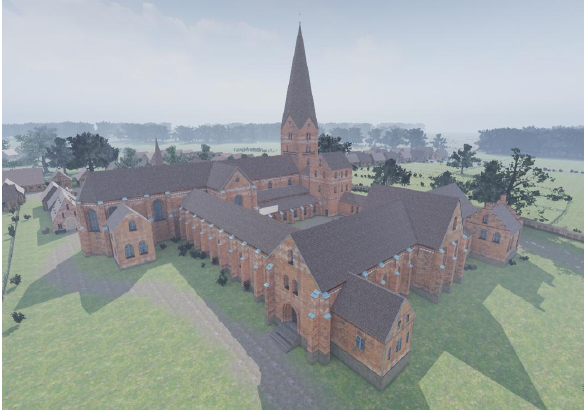
Figure 7. The reconstructed church and the monastery in Gieschenhagen, view from